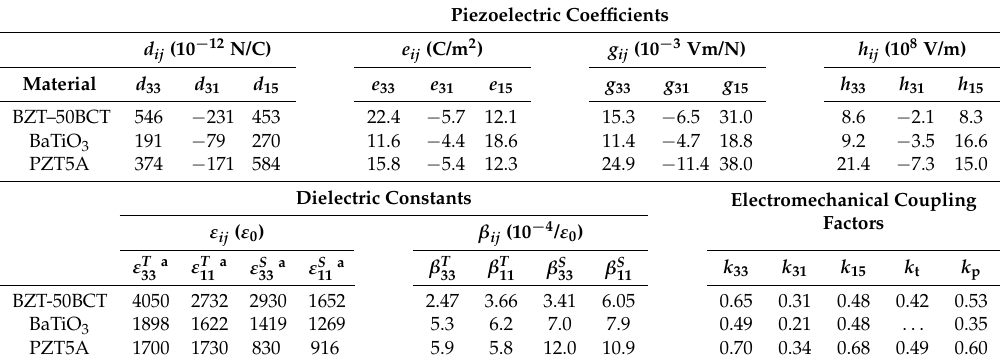
Table 3. The piezoelectric coefficients for 0.5BZT–0.5BCT